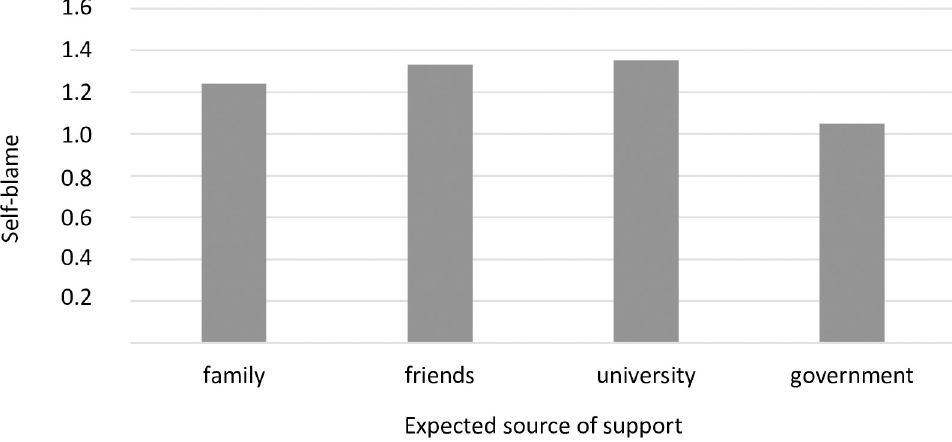
Fig 9. Students’ use of self-blame (mean) and sources of expected support during the COVID-19 pandemic (F = 3.14, p = 0.024, η 2 = 0.02).